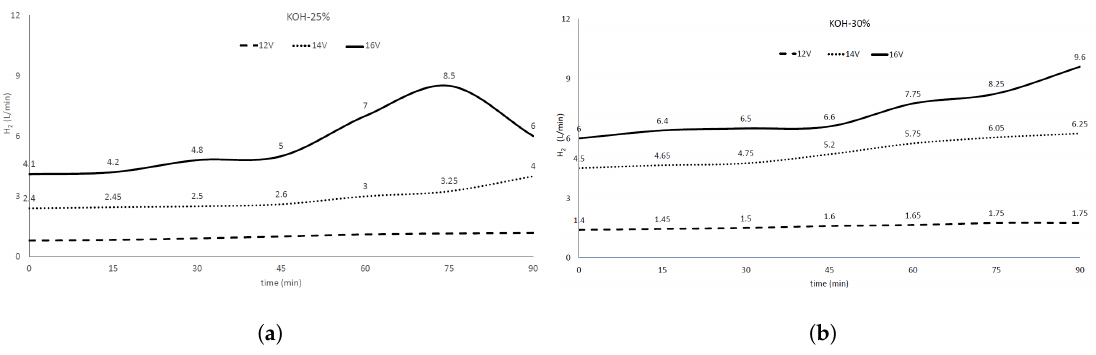
Figure 3. ( a ) H 2 production (L/min) vs. time (min) at different potentials 12, 14 and 16 V, ambient pressure and temperature 50 ◦ C. KOH at: ( a ) 25% and ( b ) 30% by